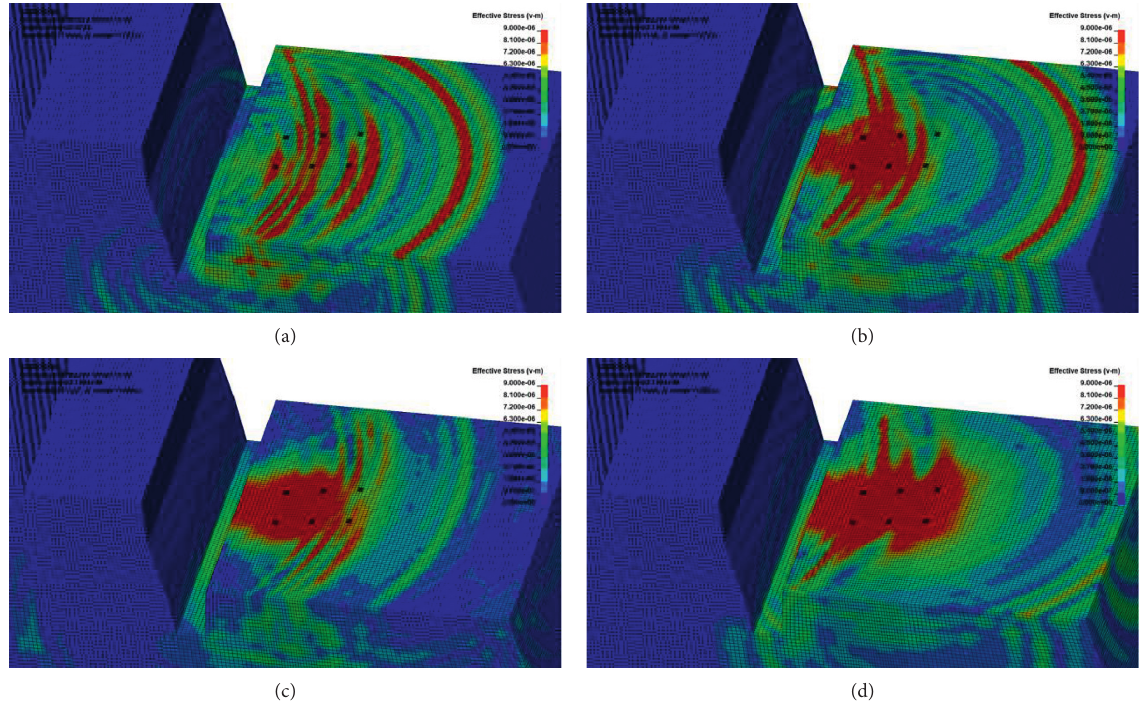
Figure 8: Stress nephogram of blasthole blasting: (a) no. 1 blasthole ( t � 30ms), (b) no. 3 blasthole ( t � 120ms), (c) no. 4 blasthole ( t � 150ms), and (d) no. 6 blasthole ( t � 240ms).